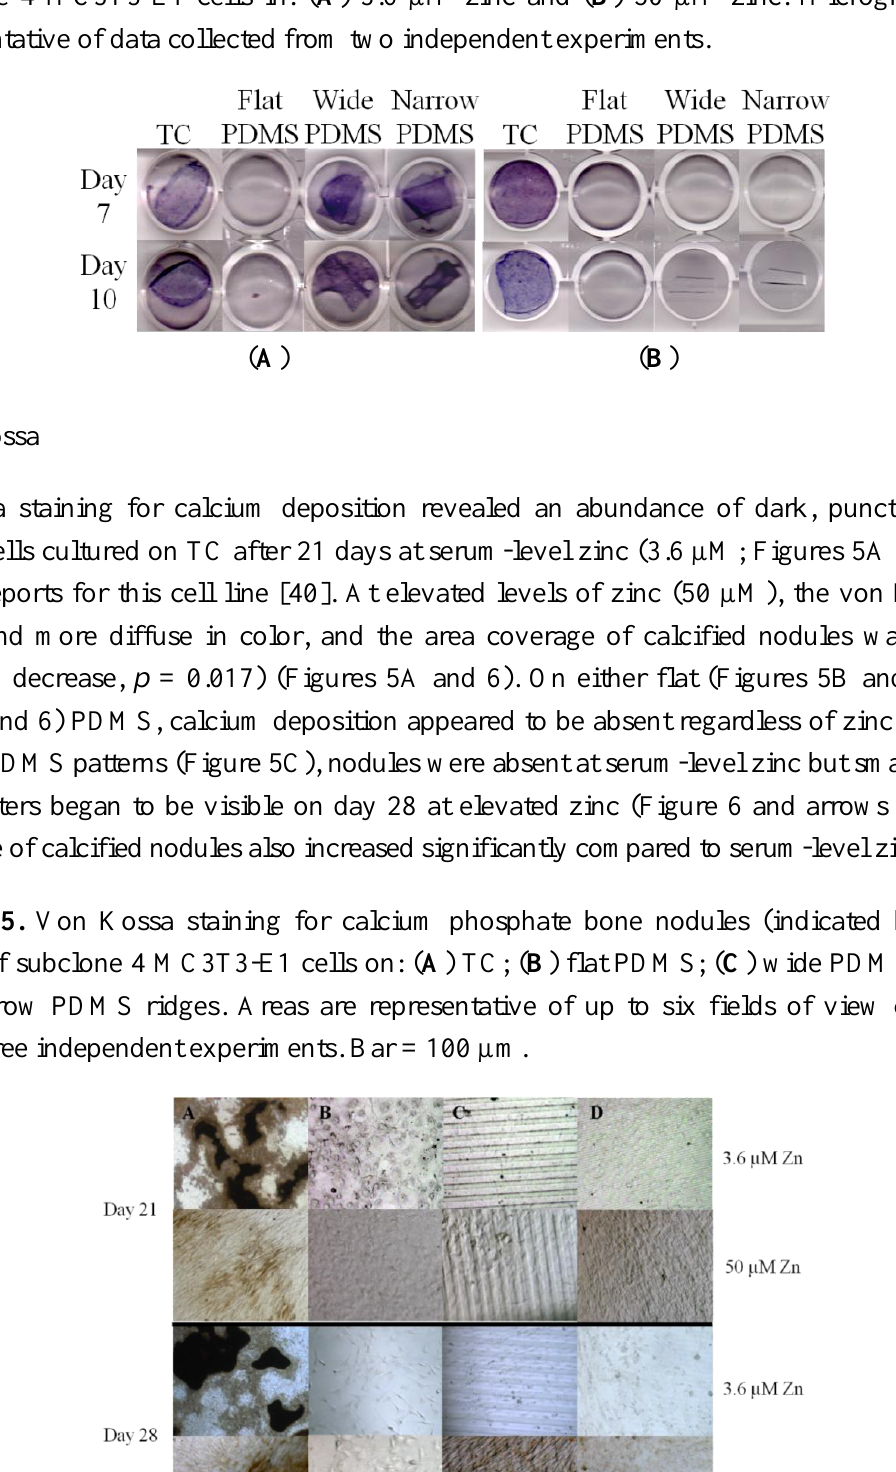
Figure 4. Alkaline phosphatase (ALP) production (indicated by dark purple color) by subclone 4 MC3T3-E1 cells in: ( A ) 3.6 µM zinc and ( B ) 50 µM zinc. Micrographs are